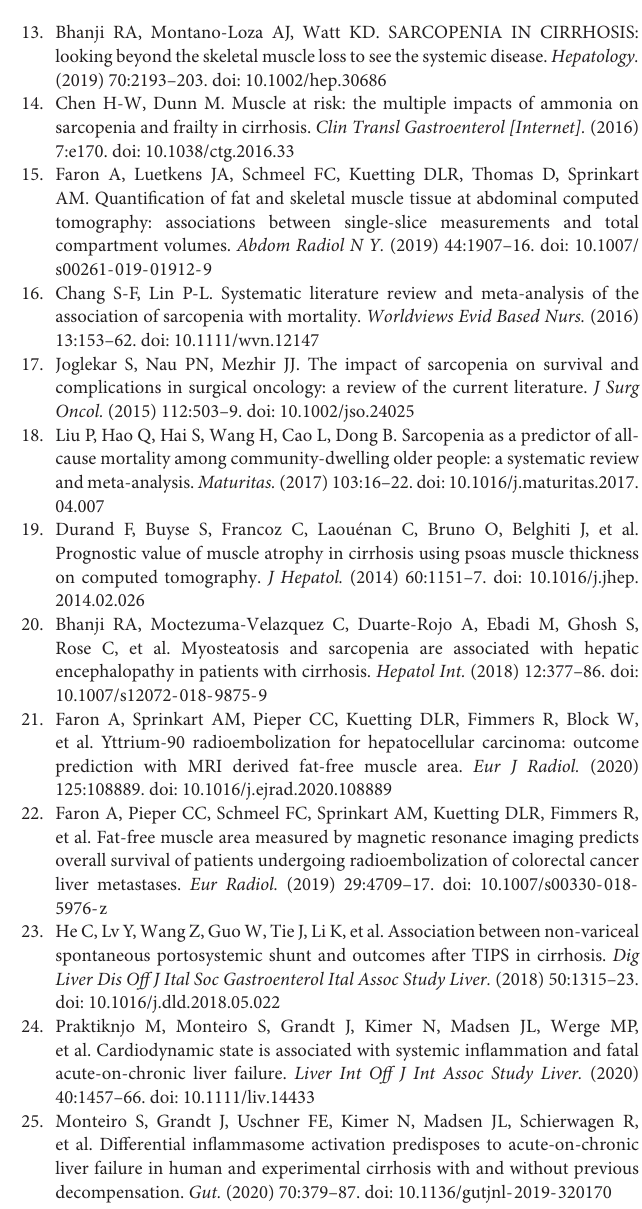
Supplementary Figure 1 | (A) Cumulative incidence of development HE in the 1-year follow-up, stratified by L3-SMI. No sarcopenia (blue line); sarcopenia (red line). P by log-rank. (B) Kaplan–Meier survival plot for 1-year survival, stratified by L3-SMI. No sarcopenia (blue line); sarcopenia (red line). P by log-rank. Supplementary Figure 2 | Correlation plot for FFMI and TSA. Supplementary Figure 3 | Competing risk analysis for HE and death/liver transplantation